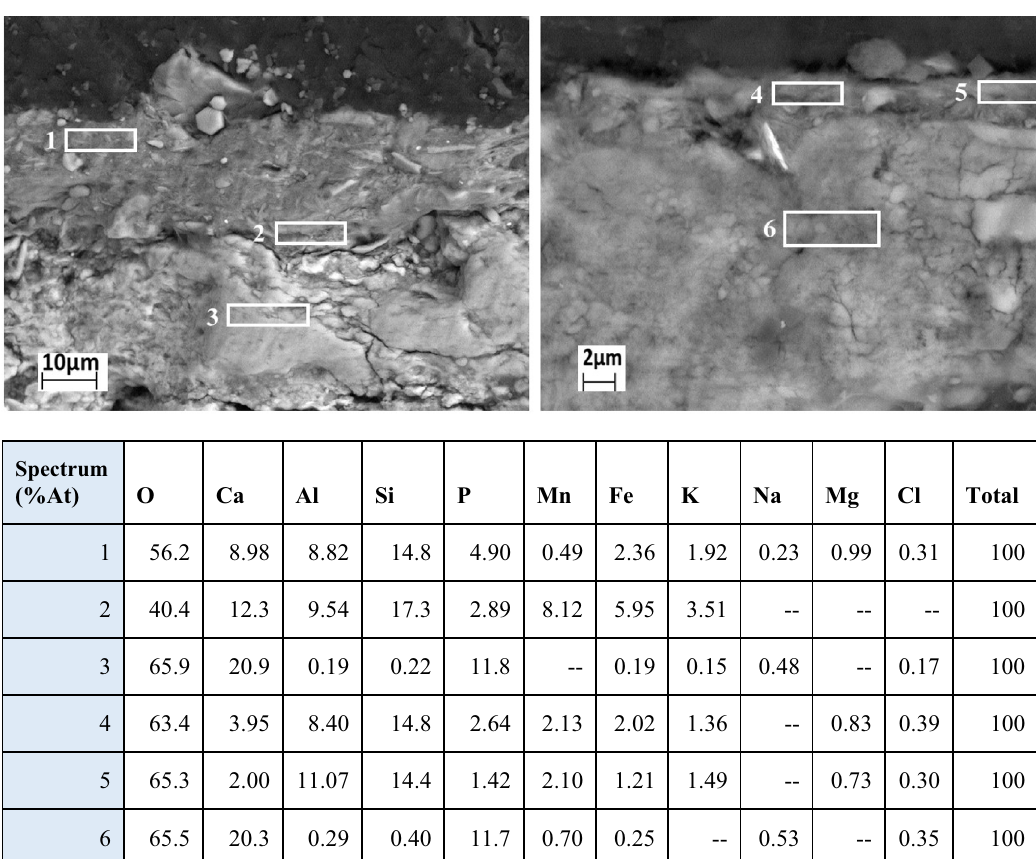
Fig. 3 Optical microscopy and SEM images obtained on the Pleis- tocene bone sample subjected to this study: ‘a and b’ correspond to the non-treated whitish original surface; ‘c and d’ to the original Mn mineralized blackish dark surface; ‘e and f’ to the n-IR laser-treated bone surface (Table 2: Region ID—5); ‘g and h’ to the laser-treated surface where melting is evident (Table 2: Region ID—4)